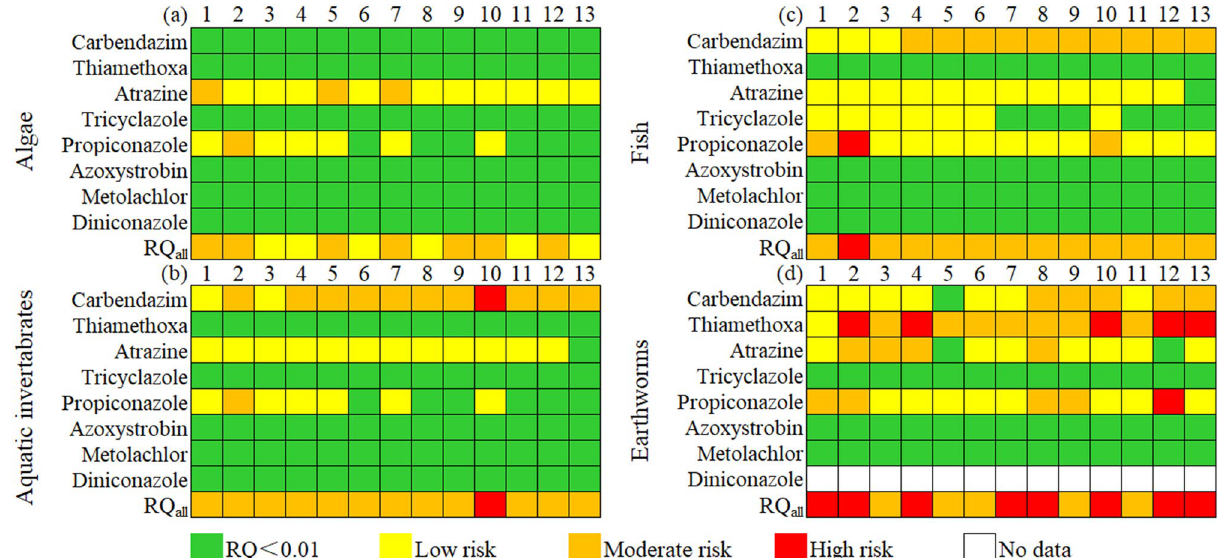
Figure 2. Heat map of RQ values of pesticides to algae ( a ), aquatic invertebrate ( b ), fish ( c ), and earthworm ( d ). Most of pesticides almost have no aquatic risk (RQ < 0.01), but carbendazim and propionazole deserved attention. The RQ all were in the range of 0.4541–3.327 (earthworm), 0.0239–0.4552 (algae), 0.1094–1.103 (aquatic invertabrates), and 0.1657–1.923 (fish),